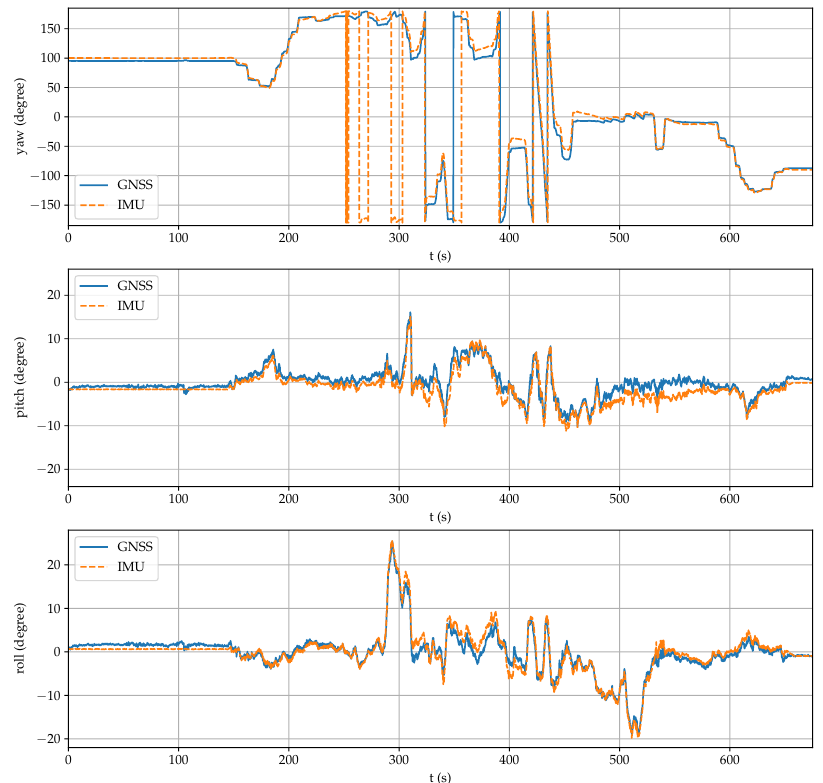
Figure 13. Comparison between the posture coordinates obtained by the IMU and the proposed